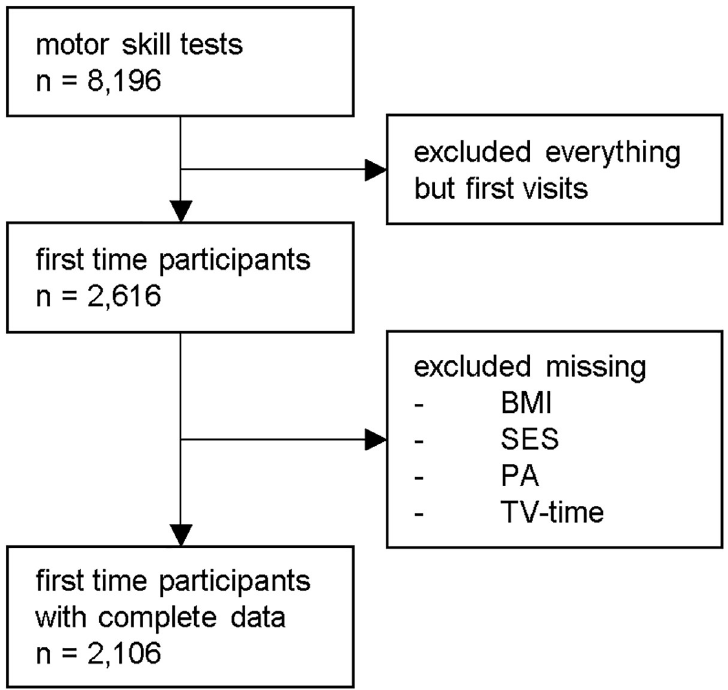
Fig 1. The final sample. BMI = Body-Mass-Index, SES = socioeconomic status, PA = physical